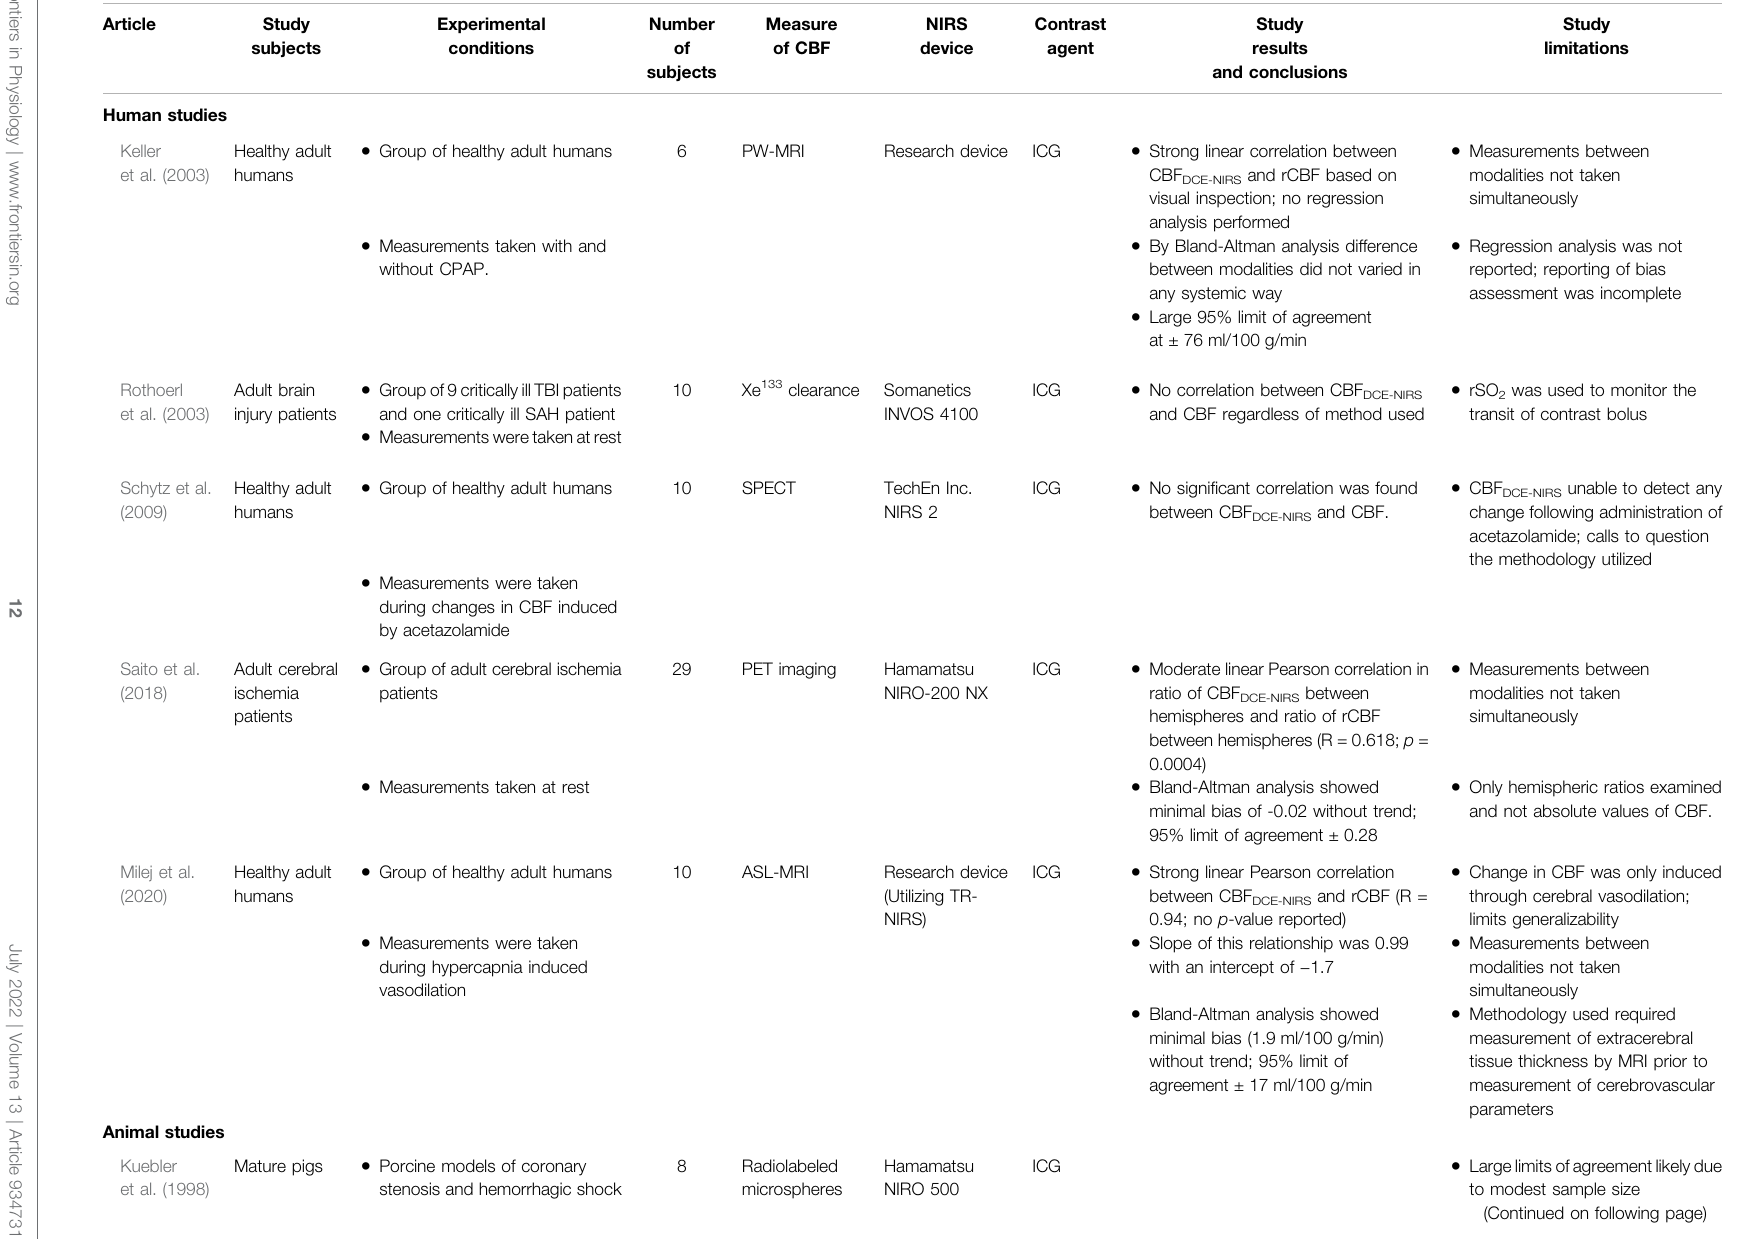
TABLE 2 | Summary of articles examining dynamic contrast enhanced near infrared spectroscopic (DCE-NIRS) cerebrovascular